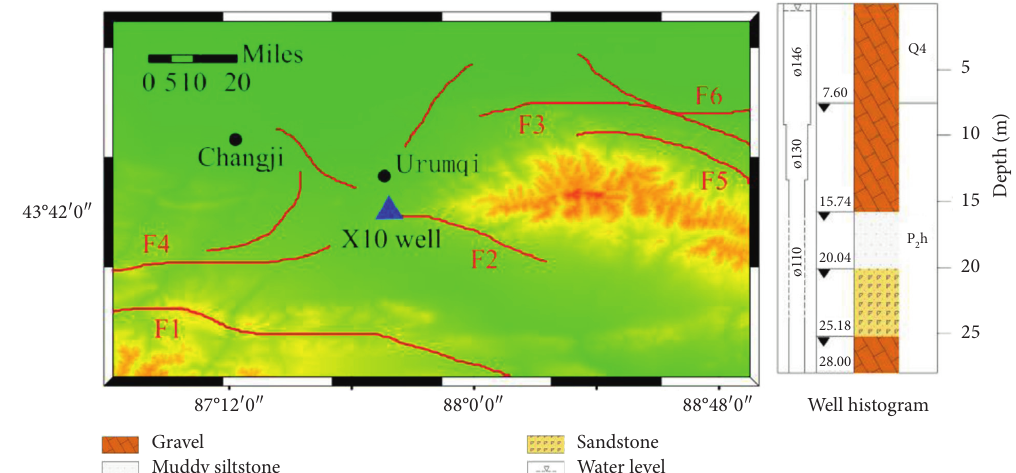
Figure 1: Location of the X10 well and stratigraphy of the borehole [16]. F1 ： southern margin fault of Chaiwopu Basin; F2: Hongyanchi Fault; F3: Yama-Kerrey Fault; F4: Xishan Fault; F5: Erdaogou Fault; F6: Fukang